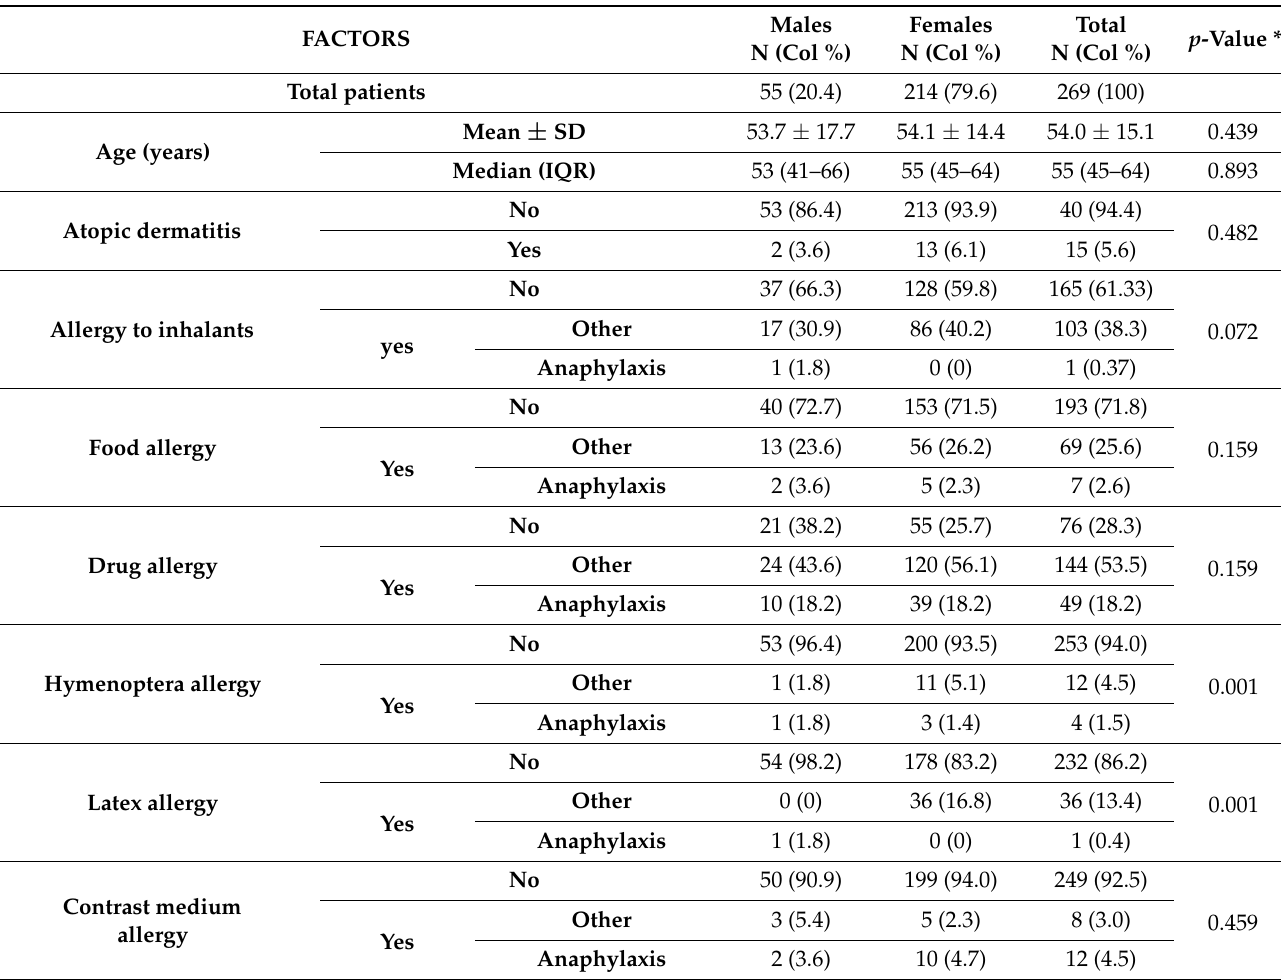
19 vaccinations occurred in 30.3% patients, 8.7% early (within 4 h) and 21.6% late (> 4 h) after immunization. Figure 2a – c show the distribution of the allergic reactions by the dose of COVD-19 vaccine received. Table 1. Distribution of the study population. Number (N); column percentage (Col %); mean (M) ± standard deviation (SD); median and interquartile range (IQR). PS80 = Polysorbate 80.